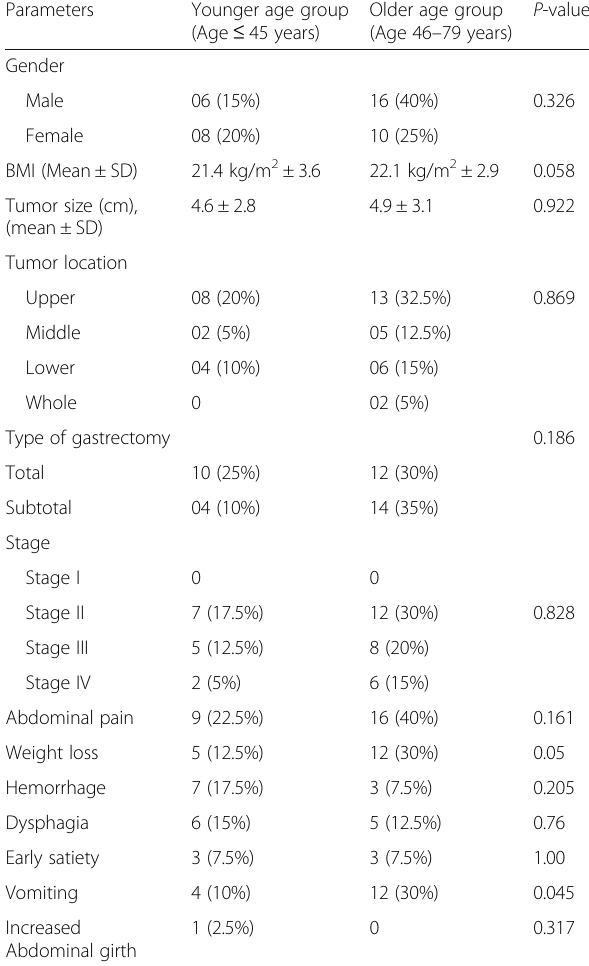
Table 2 Clinicopathological features of gastric cancer patients (Stratified by